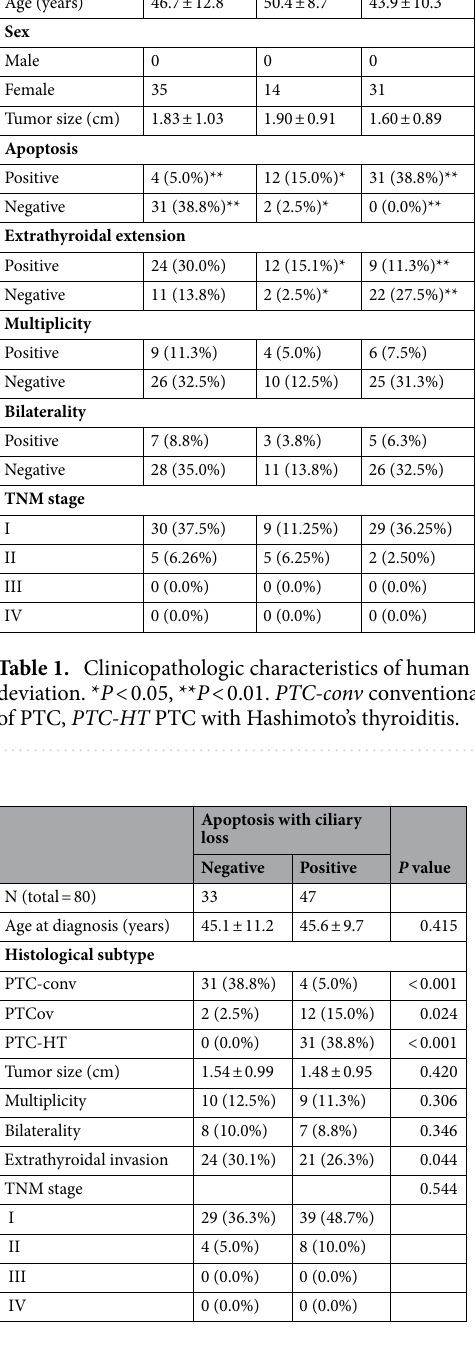
Table 2. Association between apoptosis and clinicopathological characteristics of PTCs. Data represent the mean ± standard deviation. PTC-conv conventional papillary thyroid carcinoma, PTCov oncocytic variant of PTC, PTC-HT PTC with Hashimoto’s